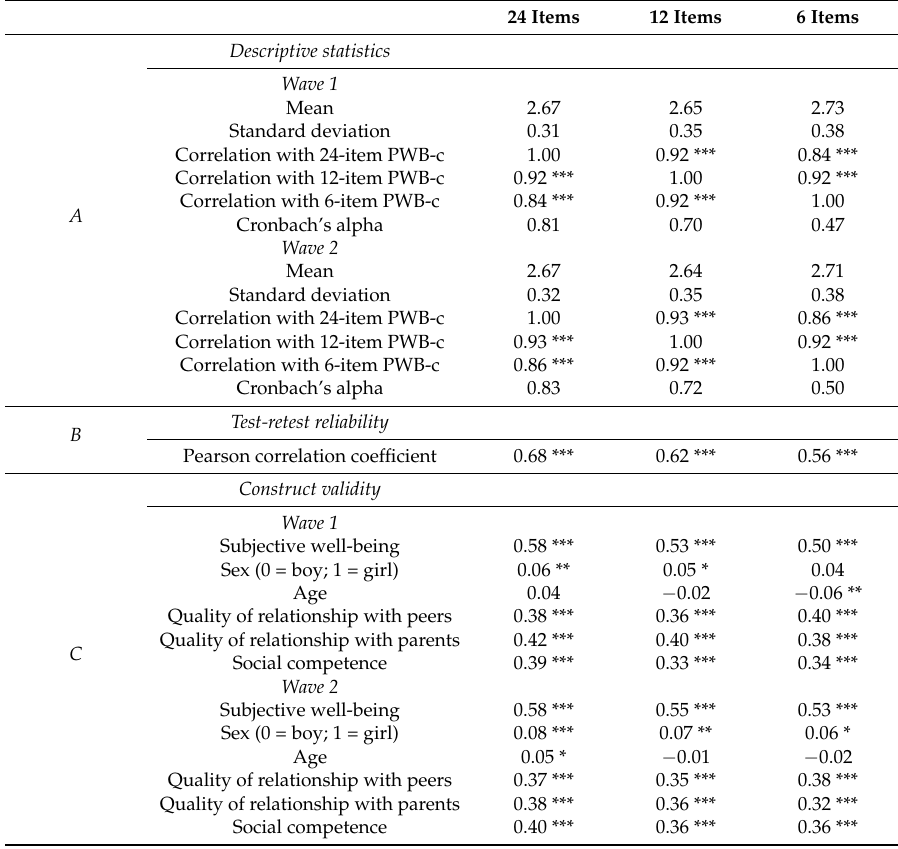
Table 3. Descriptive statistics, test-retest reliability, and construct validity of the psychological well-being scale for children observed in main study ( N = 1877). 24 Items 12